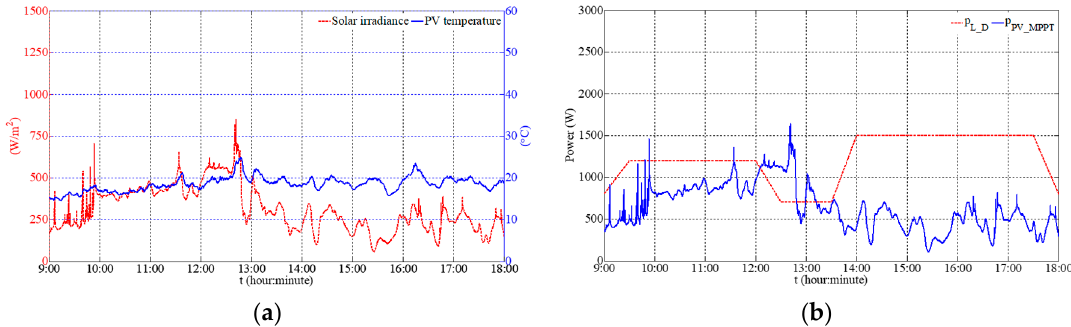
Figure 5. ( a ) Solar irradiance and photovoltaic (PV) cell temperature and ( b ) Load power demand and PV maximum power point tracking (MPPT) power.